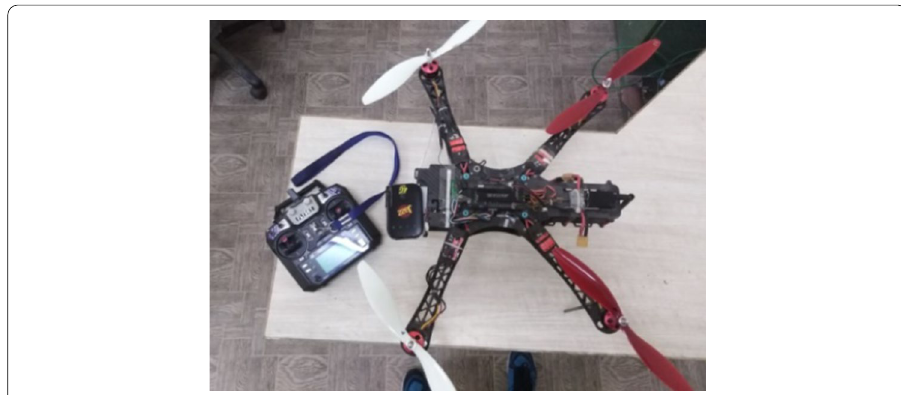
Fig. 5 Upper view-UAV prototype